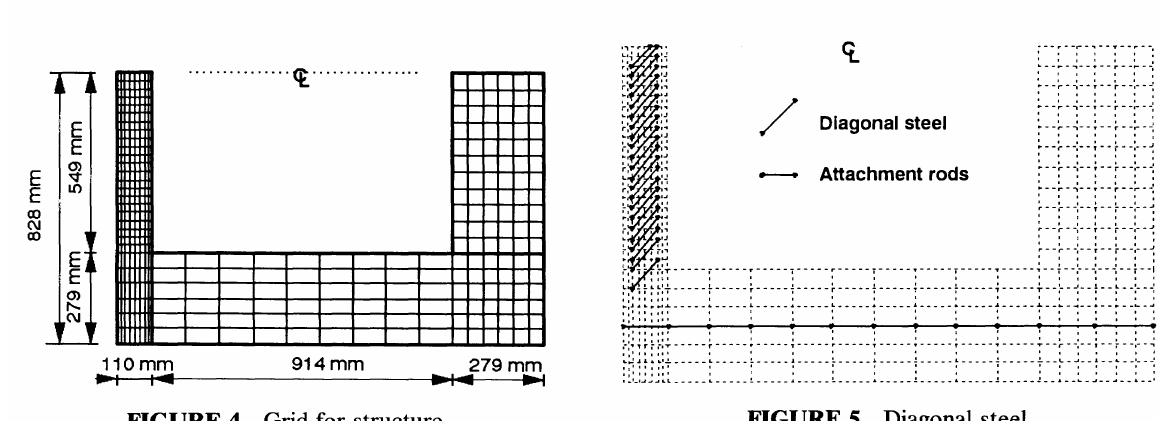
FIGURE 4 Grid for structure. FIGURE 5 Diagonal